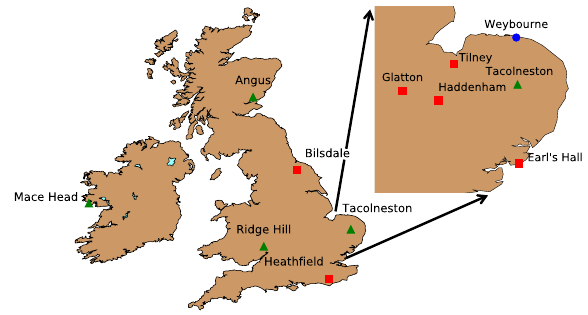
Figure 1. The UK DECC network funded by the UK govern- ment (sites denoted by green triangles, 2012–ongoing), the NERC GAUGE project (denoted by red squares, 2013–2015), and other (blue circle). Sites are described in Table 1 and Appendix A. The enlarged geographical region over East Anglia shows the church network. These sites are described in Table